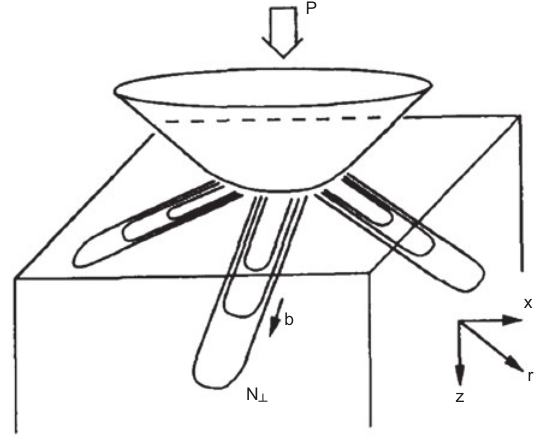
Figure 1 Schematic representation of dislocation loops emitted under the tip of a penetrating indenter.